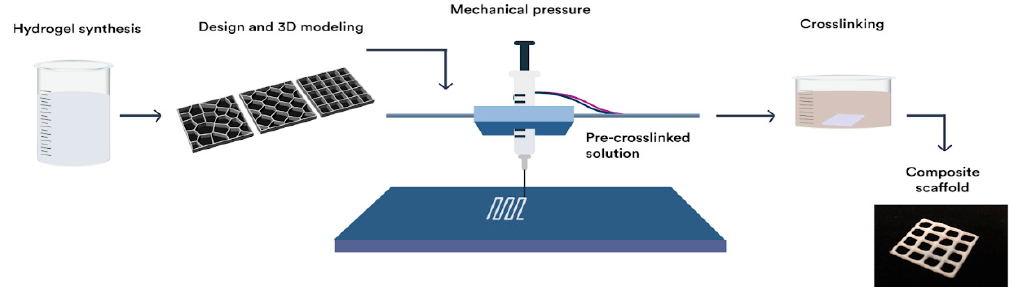
Figure 2. Illustration of printing process of the scaffolds. From synthesis of the solution, computer-aided design, extrusion computer-controlled, crosslinking of the scaffold and crosslinked printed design.